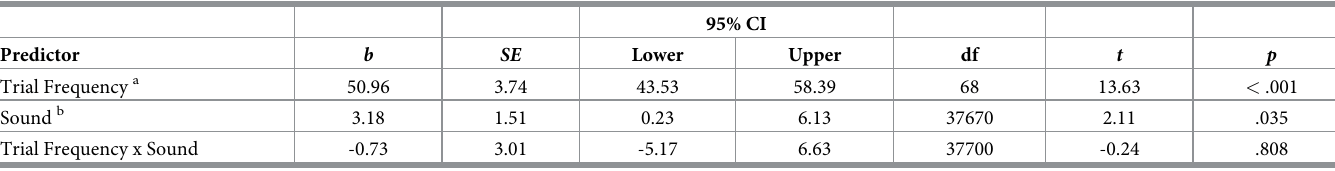
Table 1. Regression with reaction times predicted by trial frequency and sound